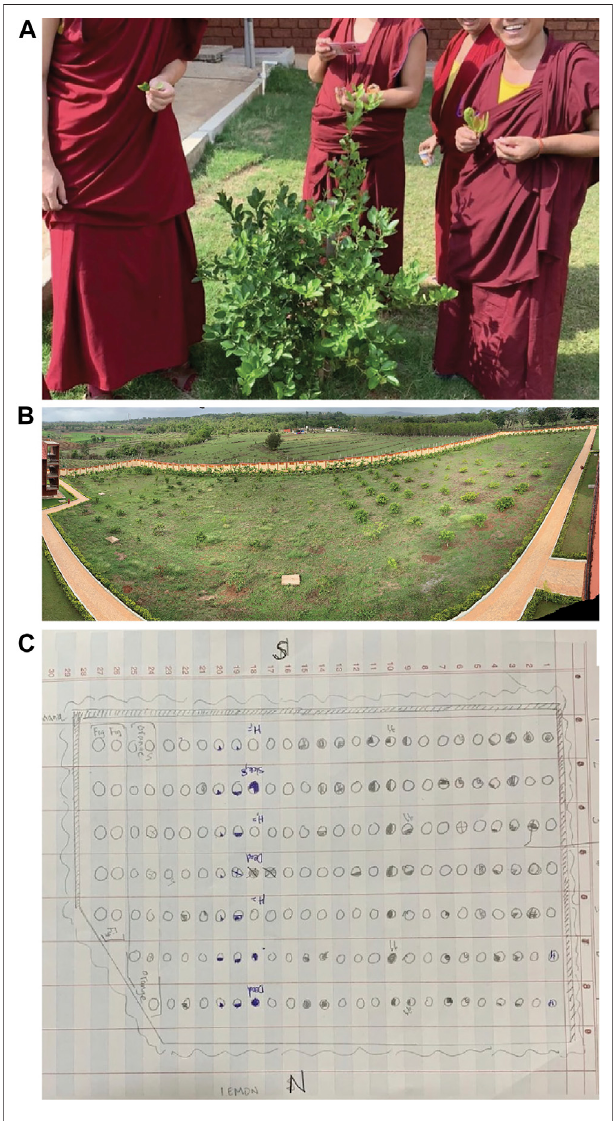
FIGURE 2 | Fungal infections in the orchard (2019 Year 5, Drepung Monastery). (A) Science monks collecting infected leaves. (B) Wide-angle photo of the infected orchard. (C) Final data sheet of the distribution and extentofinfection ineach living(circle) and deadtree (Xorentirely fi lledin circle) compiled from data collected by 23 science monks individually sampling one or two rows in the